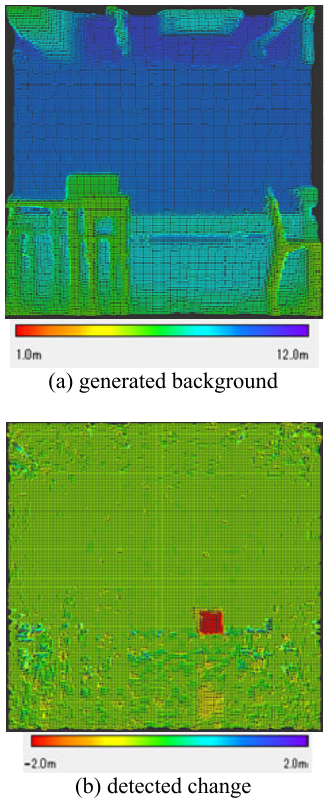
Figure 2 . Results of the proposed method (depth image).